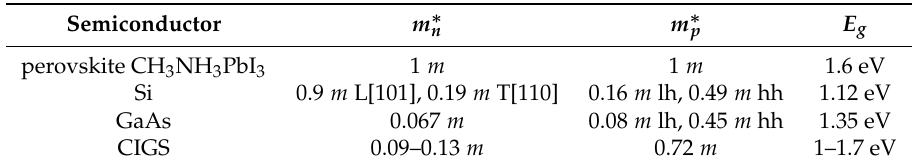
10 − 31 kg, the mass of bare ×